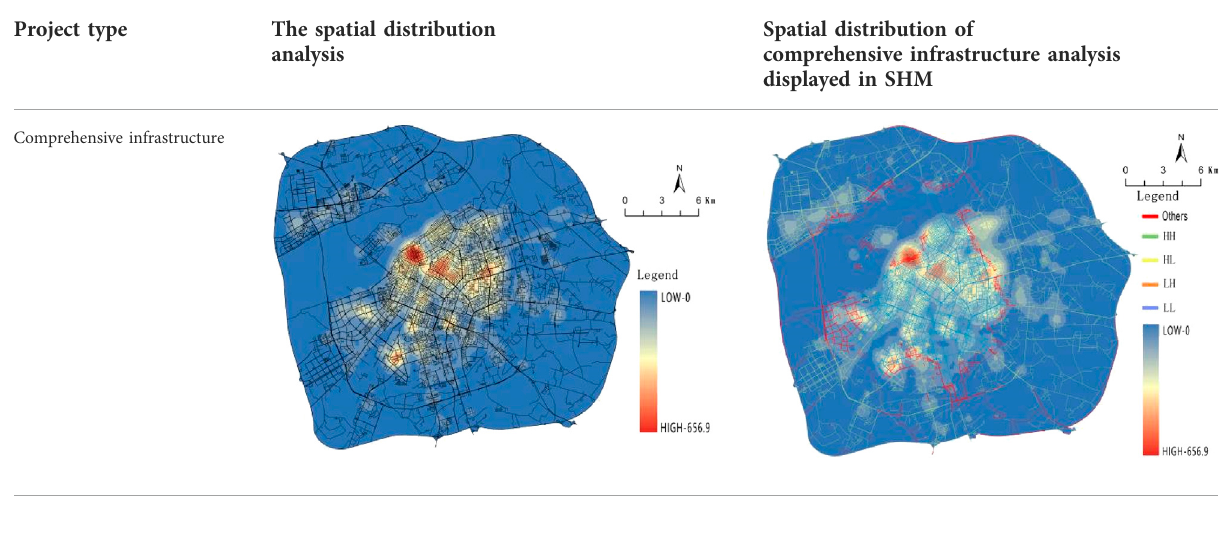
TABLE 9 Spatial distribution of comprehensive infrastructure in SHM.